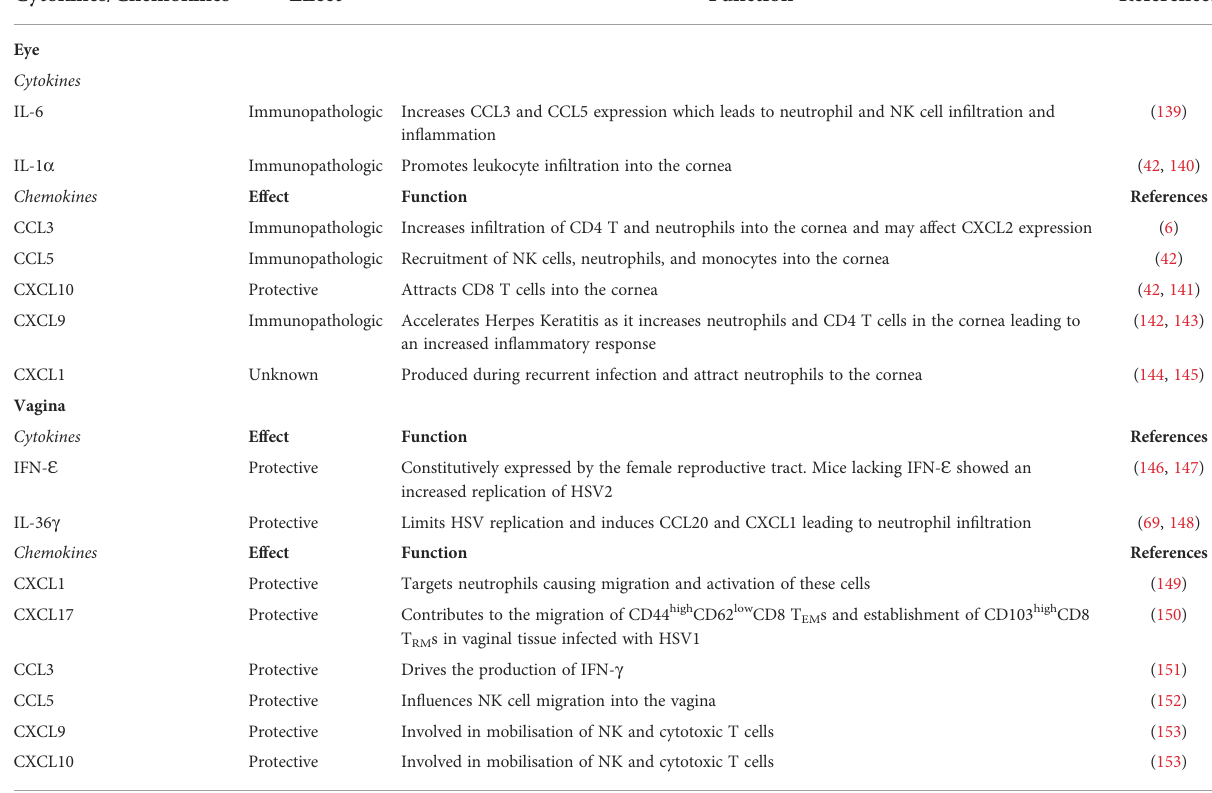
TABLE 2 Summary of known cytokines and chemokines involved in HSV infections of Eye and Vagina and their functions. Cytokines/Chemokines